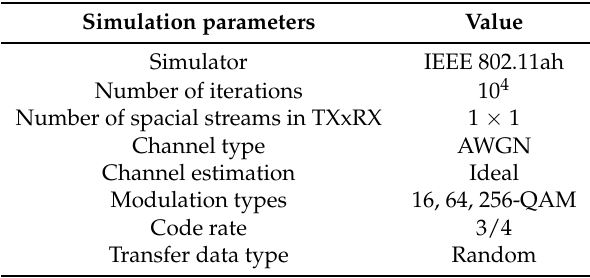
Table 3. Simulation parameters based on IEEE 802.11ah.